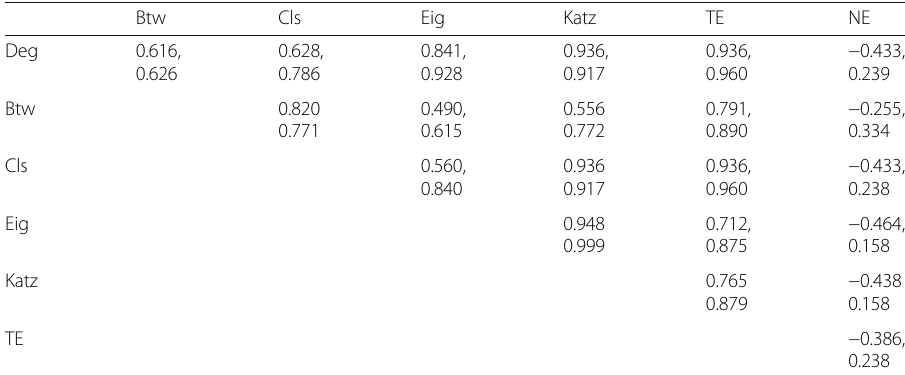
Table 9 Measuring similarity between pairs of centrality indices from Table 8. In each cell, the first value is Kendall rank correlation coefficient and the second value is RBO similarity value. TE and NE stand for total effect and net effect as derived from our new methodology Btw